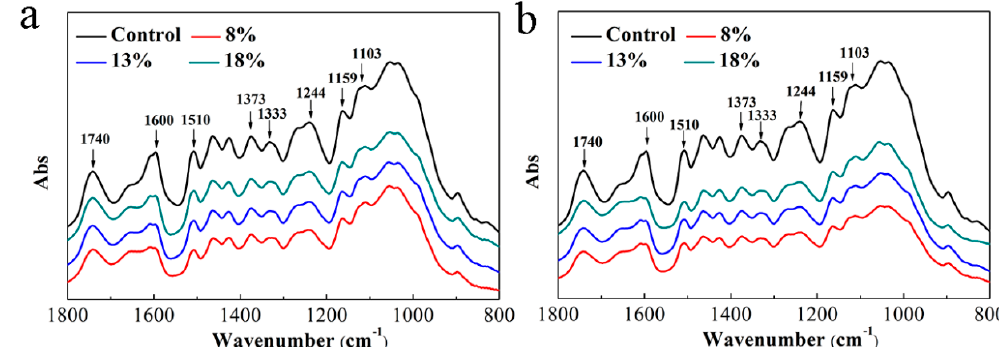
Figure 5. Fourier transform infrared (FTIR) spectra of healthy (control) and decayed OWMEC samples with different resin contents: ( a ): T. versicolor decay; ( b ): G. trabeum decay.